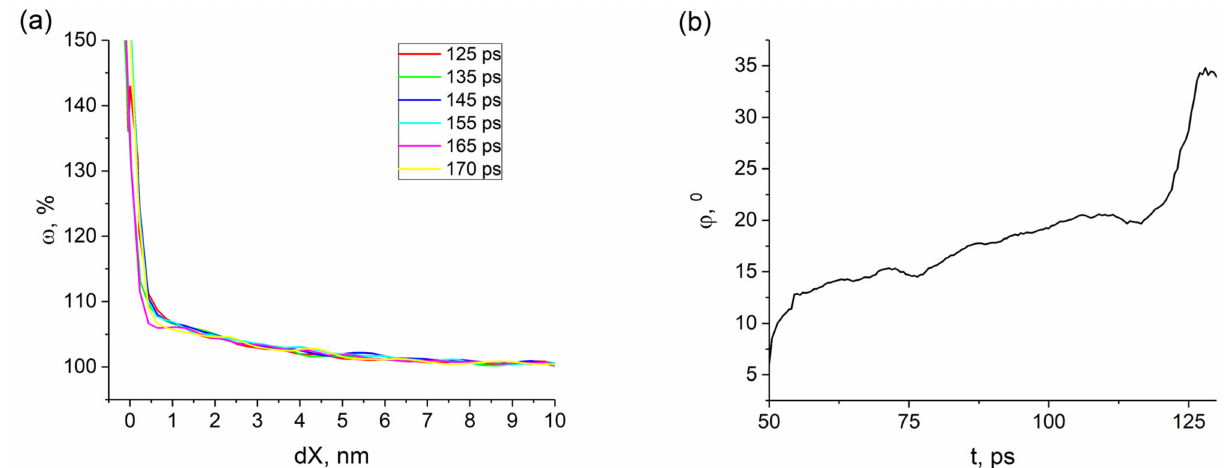
Figure 5. Distribution profile of atomic volume along the X axis relative to the crack tip of the (110)[001] crack for the corresponding points in time ( a ). Time variation of the crack opening angle ( b